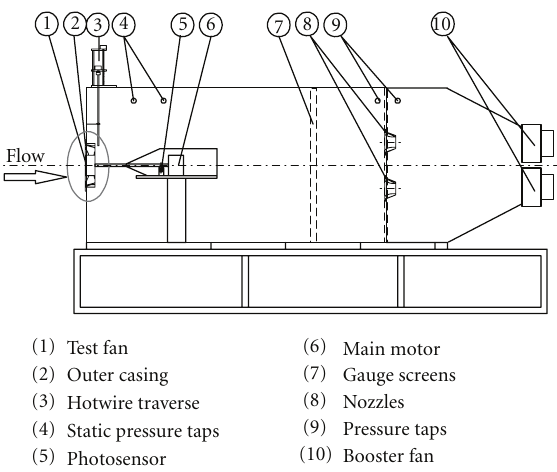
Figure 2: Schematic view of test rig and its components list.